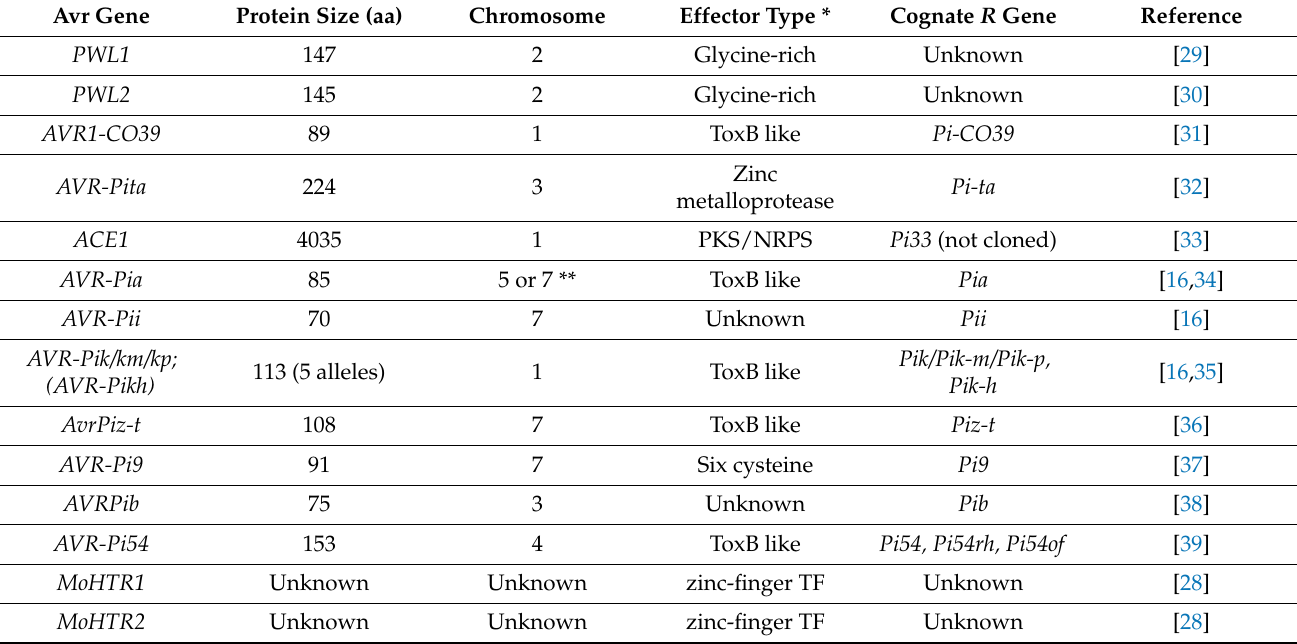
Table 2. List of Magnaporthe Avr/effector genes